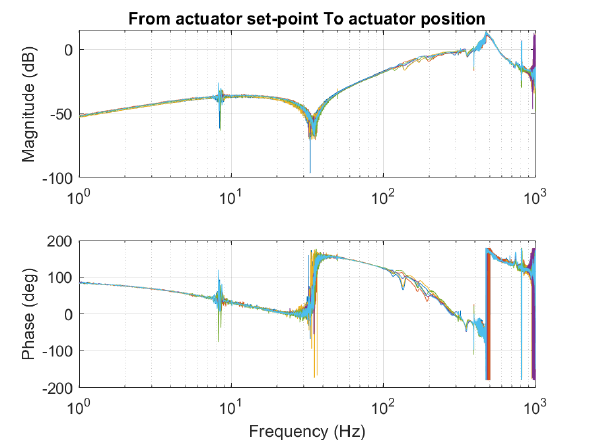
Figure 16. Closed loop cross coupled frequency response of the actuators, from actuator reference position to measured